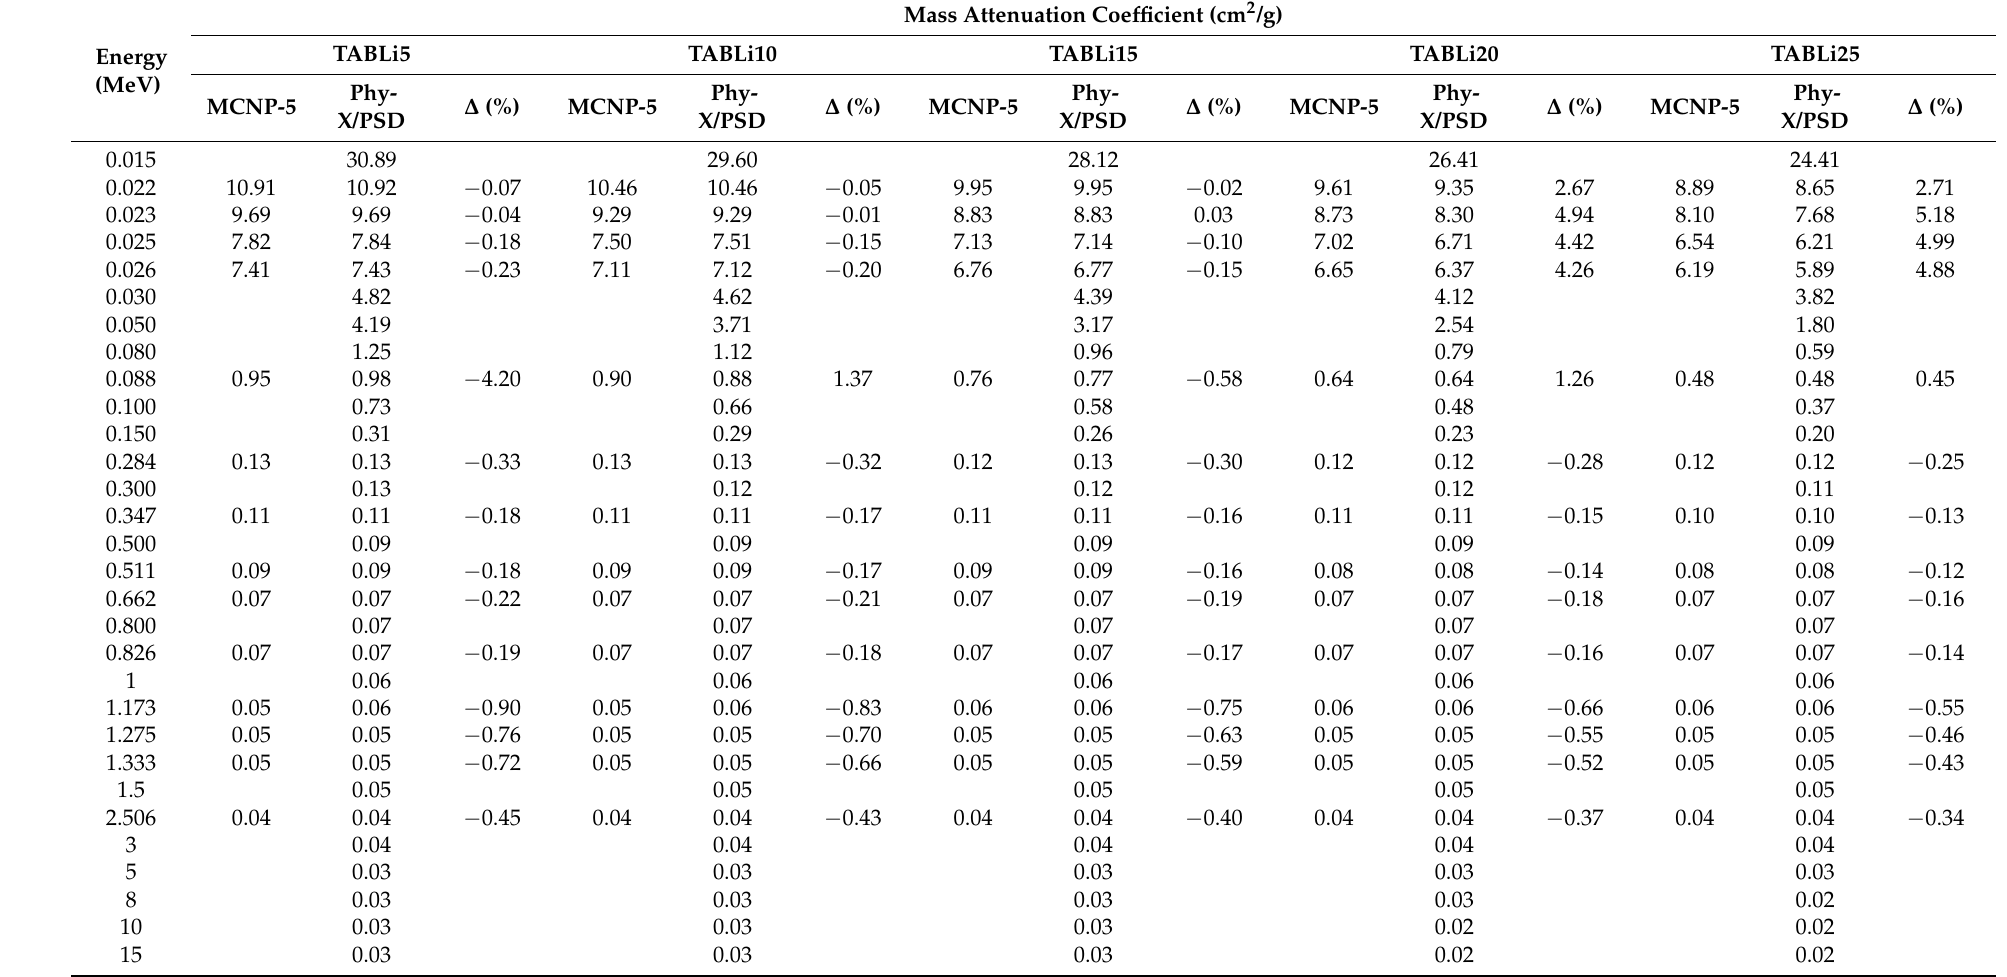
Table 3. The mass attenuation coefficient of the chosen